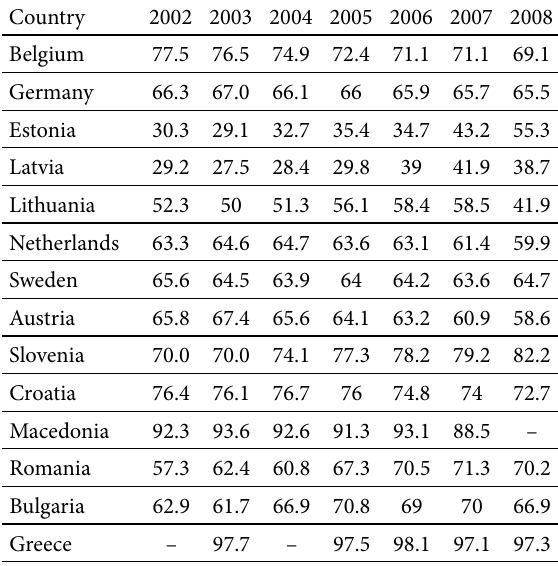
Table 1. Road share of inland freight transport (% of tonne-km) Country